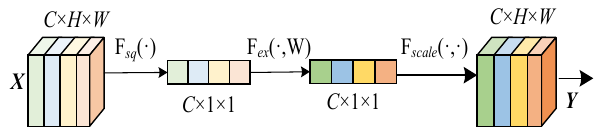
Figure 3. Squeeze-and-excitation module.